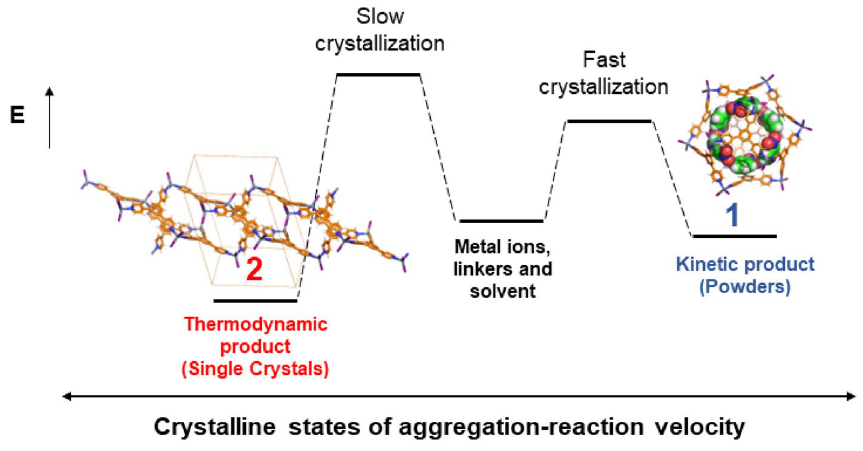
Figure 8. Kinetic control for the synthesis of M 12 L 8 poly-[ n ]-catenane 1 using instant synthesis . Slow crystallization leads to the formation of thermodynamic structures such as coordination polymer 2